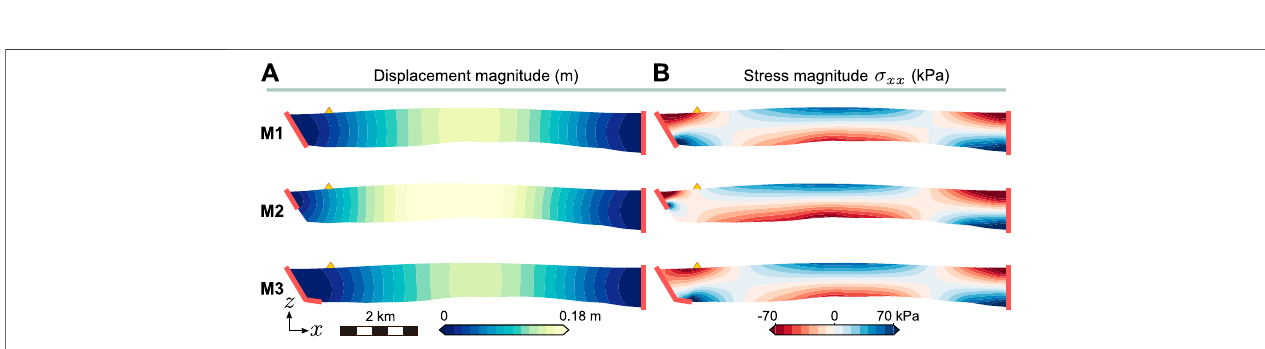
FIGURE8| Upward bending oftheice layer for three differentleft lateral boundaryconditions. M1is thereferencemodel, M2 has apartially fi xedleft boundary and M3 represents additional grounding on the sea fl oor. The fi rst column shows the displacement magnitude and the second column is the transverse (across- fl ow) componentofthestresstensor.Negativestressesarecompressiveandpositivestressesaretensile.Thetideforcingis+37 cm,representingthescaledspringhightide. All experiments have a uniform Young ’ s modulus of E = 4 GPa. Opposite downward bending of the ice layer is shown in Supplementary Section 3.4 .